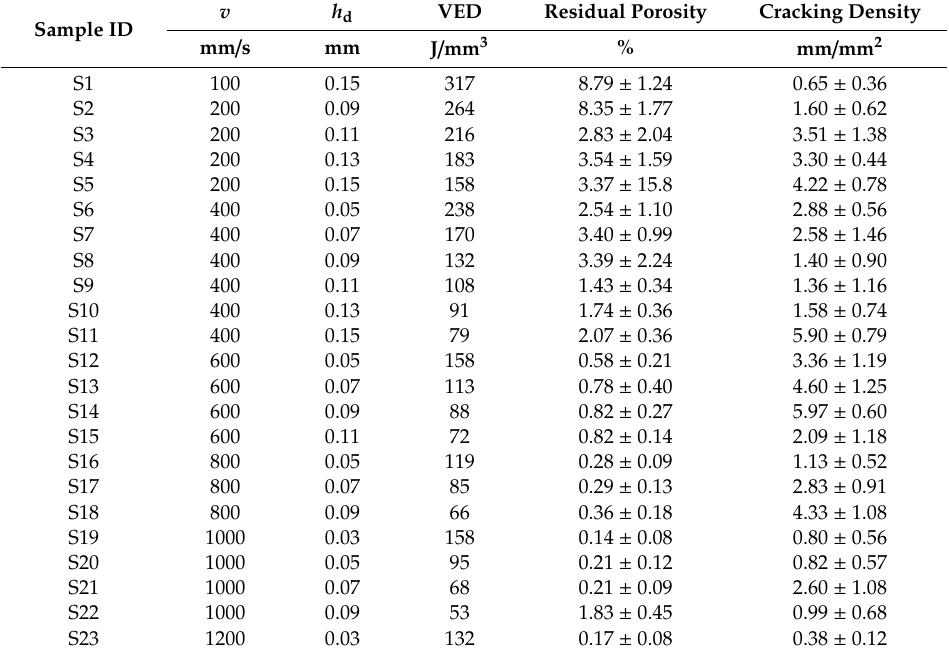
Table A1. List of the process parameters employed to fabricate the di ff erent conditions coupled to the resulting total void content obtained using porosity content and crack density. P = 95 W and t = 20 µ m are fixed parameters.